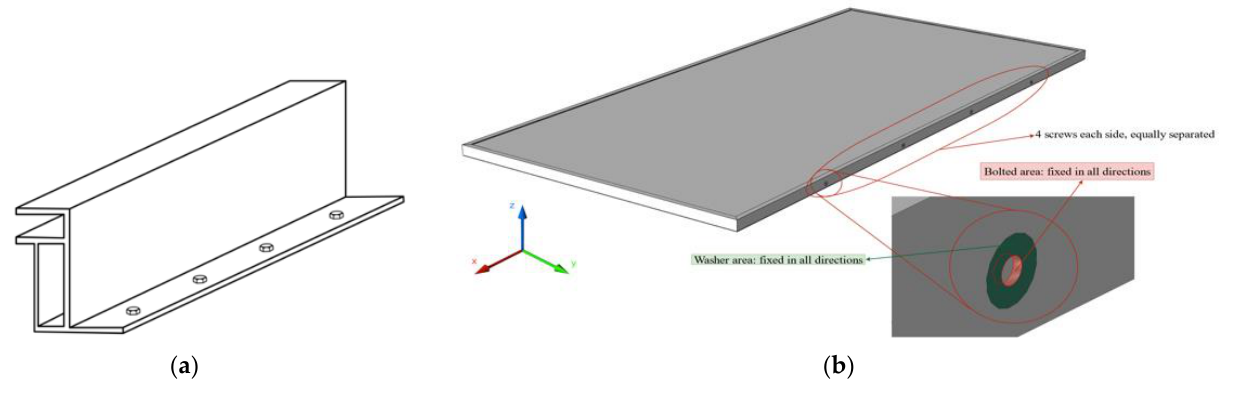
Figure 4. ( a ) ¼″ × 2 - 1/2″ lag screws connections screwed directly to the top of joists, and ( b ) connections alternatively made to the side of modules into the side of the joists.